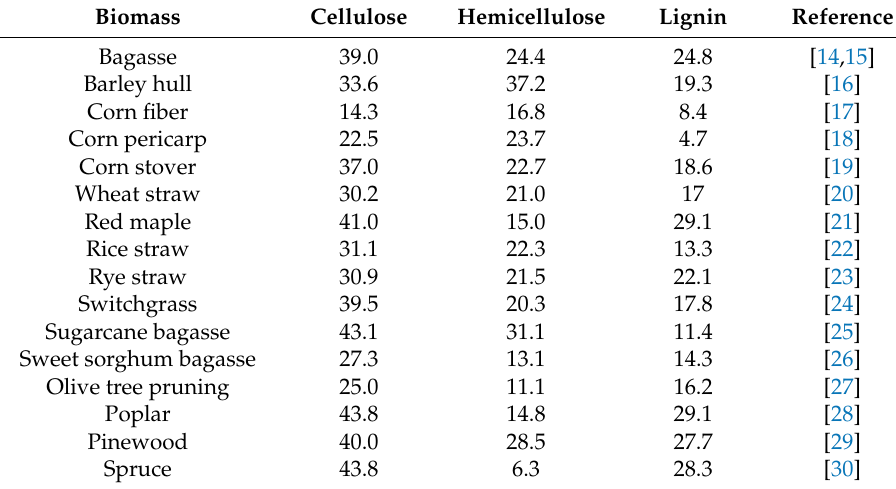
Table 1. Chemical composition of common lignocellulosic feedstocks (% dry basis). Biomass